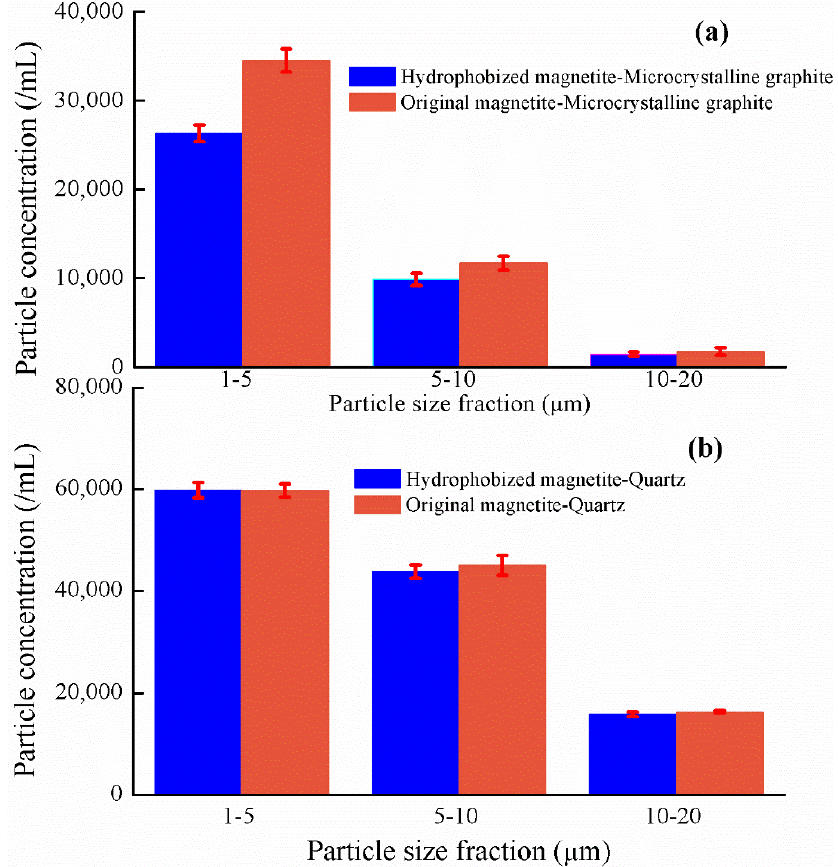
Figure 6. The particle concentrations of the supernatant after original magnetite/hydrophobized magnetite agglomerates with ( a ) microcrystalline graphite and ( b ) quartz. The error bars represent the standard deviation of multiple replicates.